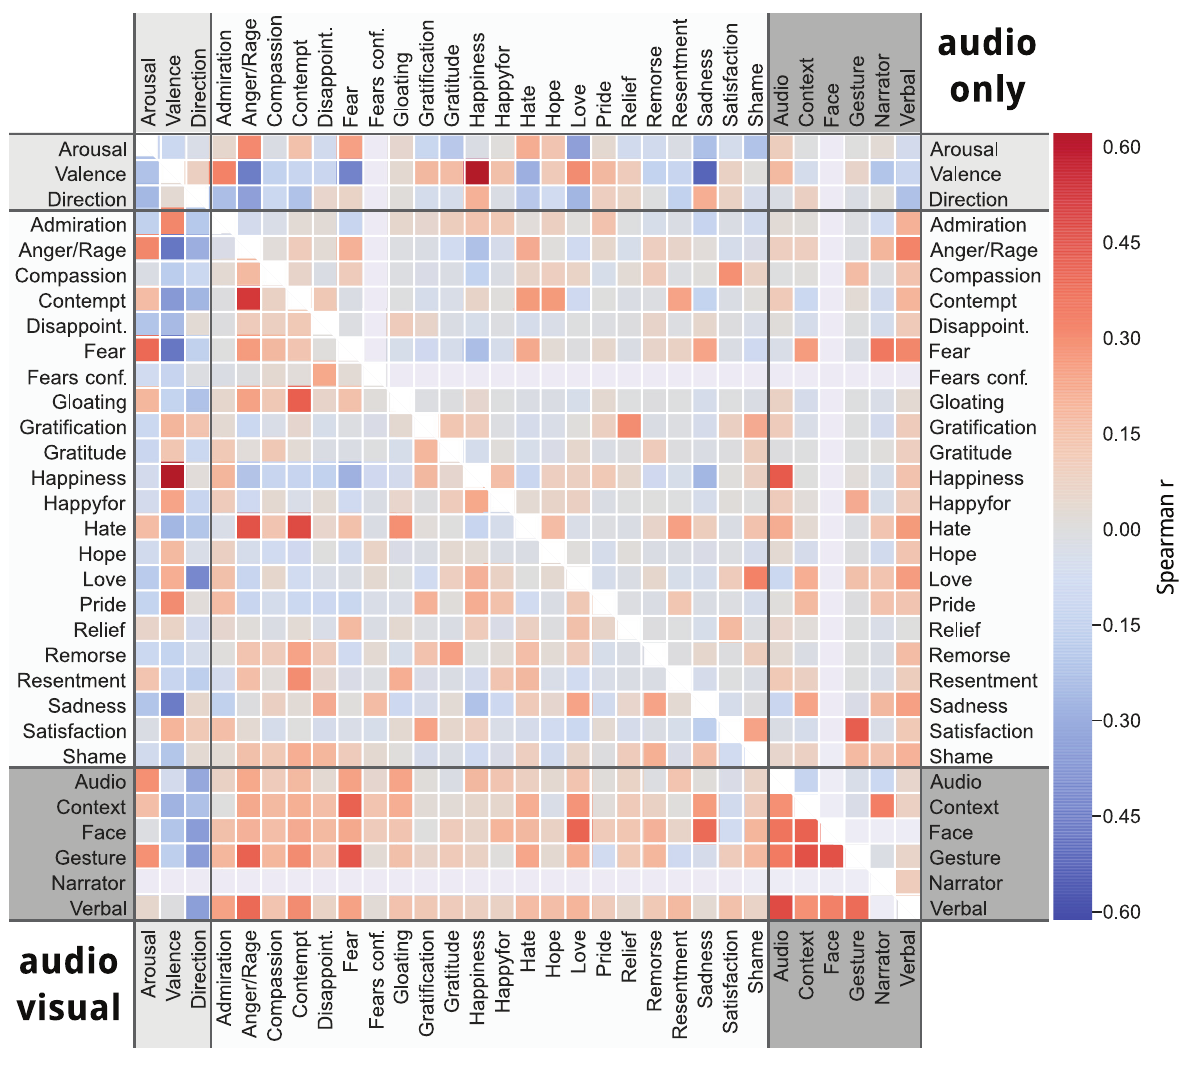
Figure 4. Intra-stimulus indicator correlation. The lower triangular matrix depicts the correlations between the IOA time courses for the three primary bipolar emotion attributes (arousal [high/low], valence [pos/neg], and direction [self/other]), the 22 emotion categories, and the six emotion onset indicators for the audio-visual movie. The upper triangular matrix shows the corresponding correlations for the audio-only movie. There were no observations for the emotion “fears confirmed”, or the facial expression onset cue in the audio-only movie. Likewise, there were no observations for the “narrator” onset cue in the audio-visual movie. The corresponding undefined correlations are depicted as